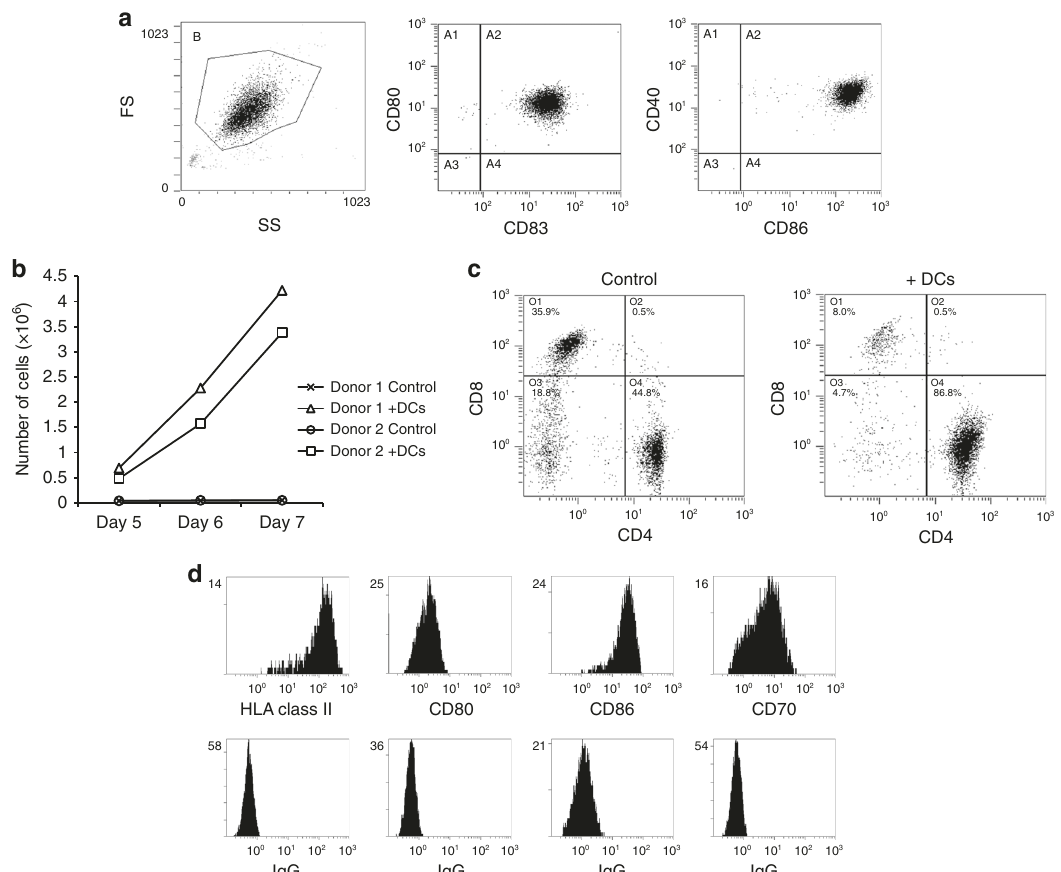
Fig. 1 Fully mature DCs induce lymphocyte proliferation and enrichment for T H cells. a Flow-cytometric analysis of the expression of CD40, CD80, CD83 and CD86 on the DCs used for stimulation of lymphocyte proliferation. b PBLs from two healthy donors cultured in the presence or absence of fully mature DCs. Shown are total numbers of large lymphocytes (>9 µ m). c Flow-cytometric analysis of CD4 and CD8 expression in lymphocyte cultures grown for 6 days in the presence or absence of fully mature DCs. d Flow-cytometric analysis of the expression of the indicated markers on DC-induced